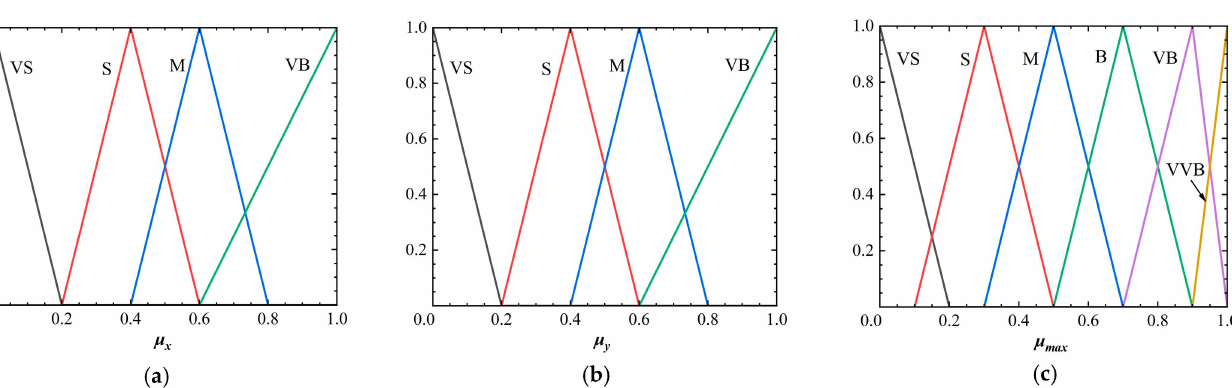
Figure 11. Affiliation function for peak pavement adhesion coefficient. ( a ) Affiliation function for the longitudinal attachment coefficient. ( b ) Affiliation function for lateral attachment coefficient. ( c ) Pavement peak adhesion coefficient affiliation